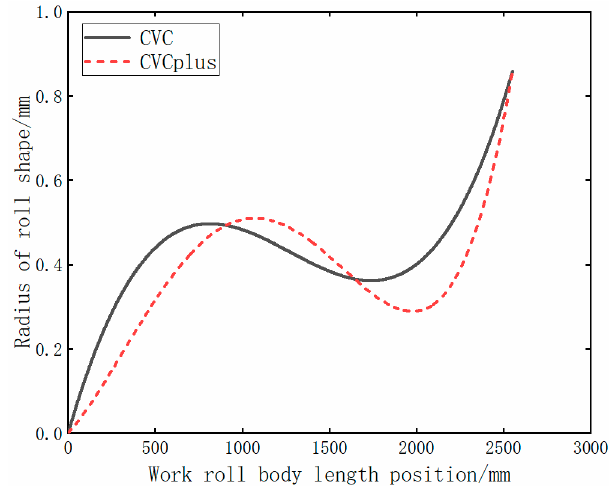
Figure 3. Curve of CVCplus.